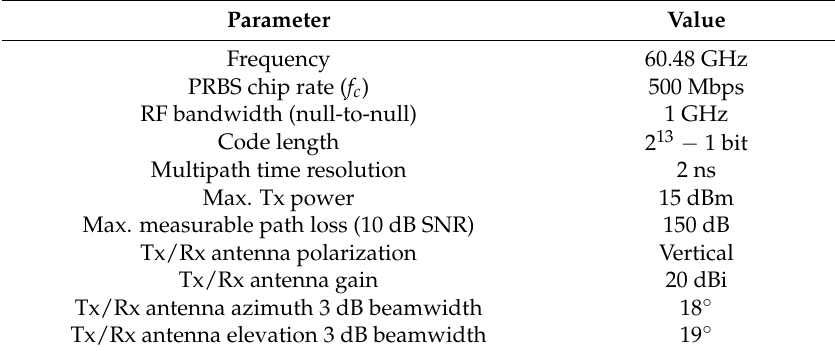
Table 1. Sounder specifications. PRBS: pseudorandom binary sequence; Tx: signal transmitter; Rx: signal